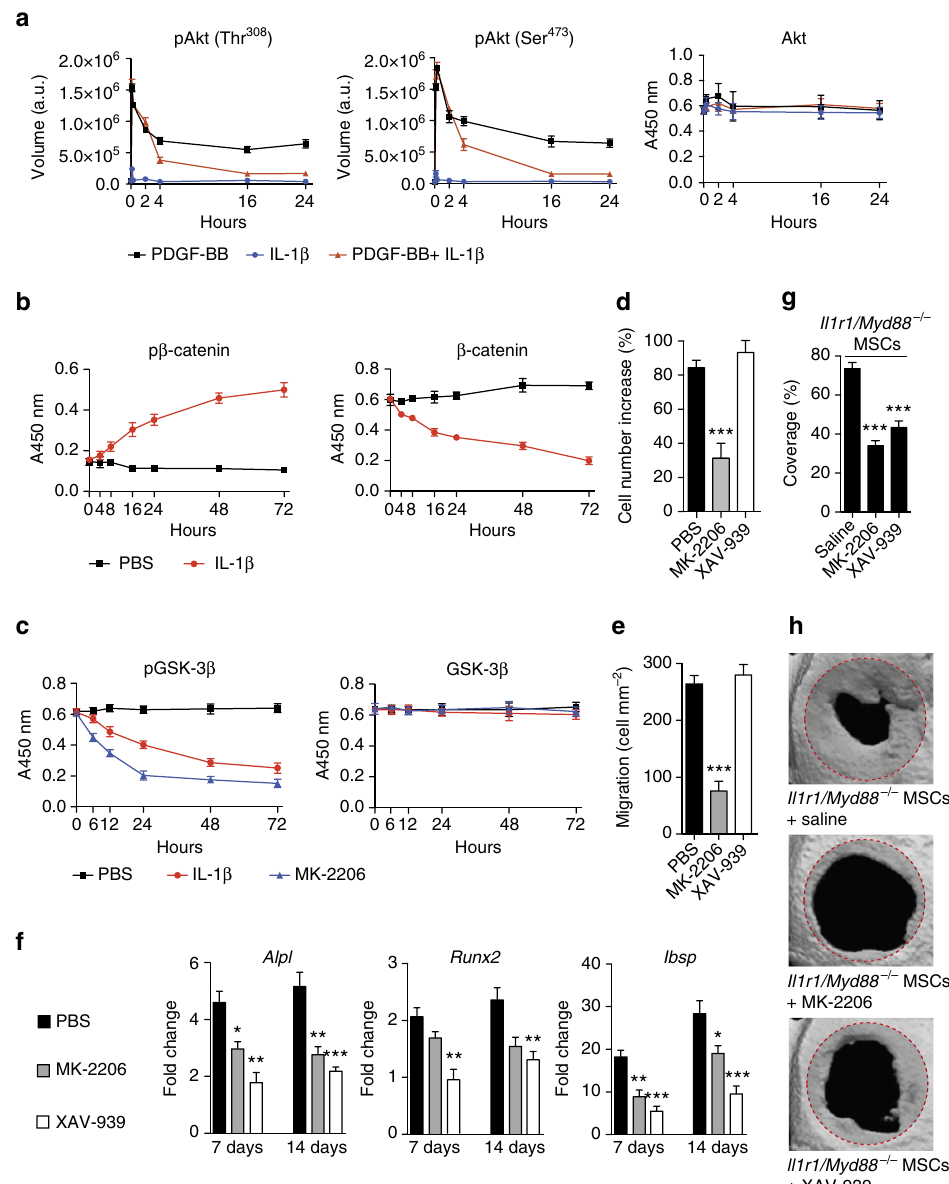
Figure 6 | IL-1R1/MyD88 signalling impairs MSC functions via inhibition of the Akt/GSK-3 b / b -catenin pathway. ( a ) MSCs were stimulated with PDGF-BB (5ngml (cid:2) 1 ), IL-1 b (1ngml (cid:2) 1 ) or both. Phosphorylation of Akt at Thr 308 and Ser 473 was quantified using an antibody array. Akt was measured by enzyme-linked immunosorbent assay. ( b , c ) MSCs were treated with IL-1 b (1ngml (cid:2) 1 ). Phosphorylated b -catenin (p b -catenin), total b -catenin, phosphorylated GSK-3 b (pGSK-3 b ) and total GSK-3 b were quantified using enzyme-linked immunosorbent assay. ( d ) MSC proliferation was stimulated by PDGF-BB (5ngml (cid:2) 1 ) with PBS, Akt inhibitor (MK-2206, 10 m M), or b -catenin inhibitor (XAV-939, 10 m M). After 72h, cell number increase was measured. ( e ) Migration of MSCs through a migration transwell was induced by PDGF-BB (5ngml (cid:2) 1 ) with PBS, MK-2206 (10 m M), or XAV-939 (10 m M). After 6h, the number of cells per square millimetre that passed through the transwell was counted. ( f ) MSCs in osteogenesis induction medium were treated with PBS, MK-2206 (10 m M), or XAV-939 (10 m M). After 7 and 14 days, expression of osteoblast-specific genes was determined by quantitative PCR. Fold changes in gene expression relative to MSCs cultured in normal medium are shown. Alpl , alkaline phosphatase; Runx2 , runt-related transcription factor 2; Ibsp, integrin-binding sialoprotein. For a – f data are means ± s.e.m. ( n Z 3). ** P o 0.01, *** P o 0.001; Student’s t -test. ( g , h ) Critical size calvarial defects (5mm diameter) in mice were treated with Il1r1 / Myd88 (cid:2) / (cid:2) MSCs co-delivered in fibrin matrix with saline, MK-2206 (1mM), or XAV-939 (1mM). Four weeks after treatment, bone regeneration was measured by microCTas coverage of the defect. Data are means ± s.e.m. ( n ¼ 6 per condition). ANOVA with Bonferroni post hoc test for pair-wise comparisons; *** P o 0.001. Representative calvarial reconstructions are shown in h . Original defect area is shaded with a red dotted outline. ANOVA, analysis of